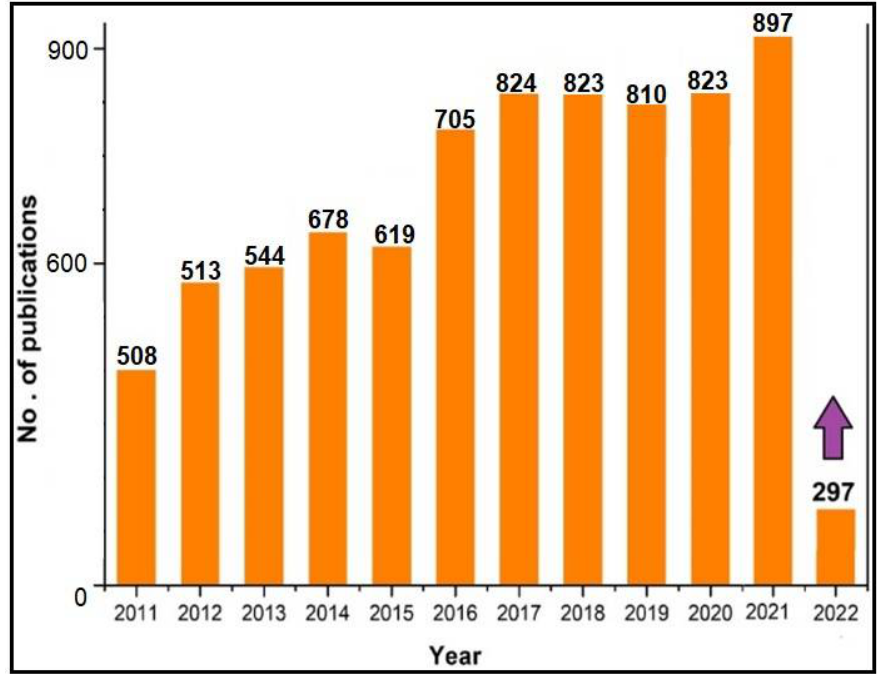
Figure 2. Year-wise data published on thermal barrier coatings.